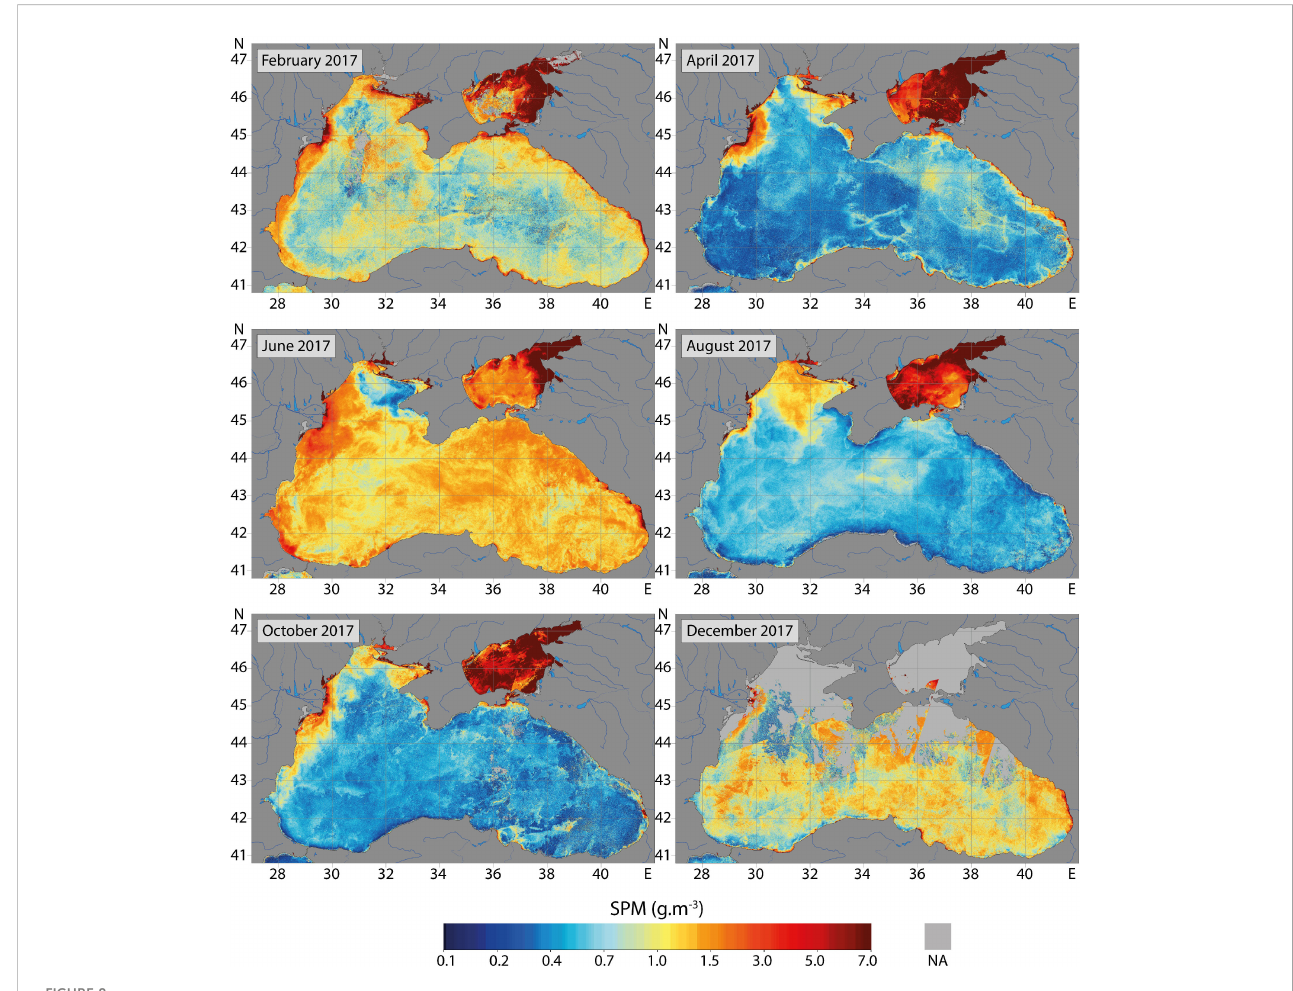
FIGURE 8 EO4SIBS SPM concentration maps (monthly composites) during selected months of